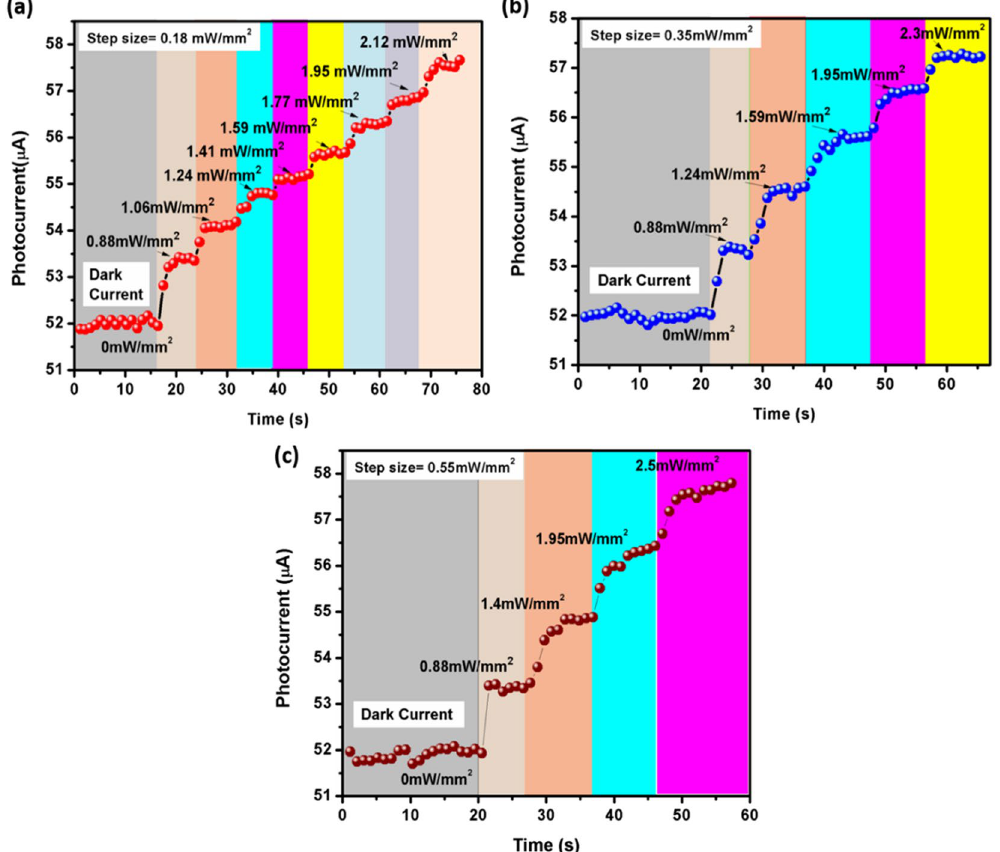
Figure 9. Dynamic photocurrent response curve for λ exc ~ 635 nm with different excitation power density step sizes: ( a ) 0.18 mW/mm 2 , ( b ) 0.35 mW/mm 2 , and ( c ) 0.55 mW/mm 2